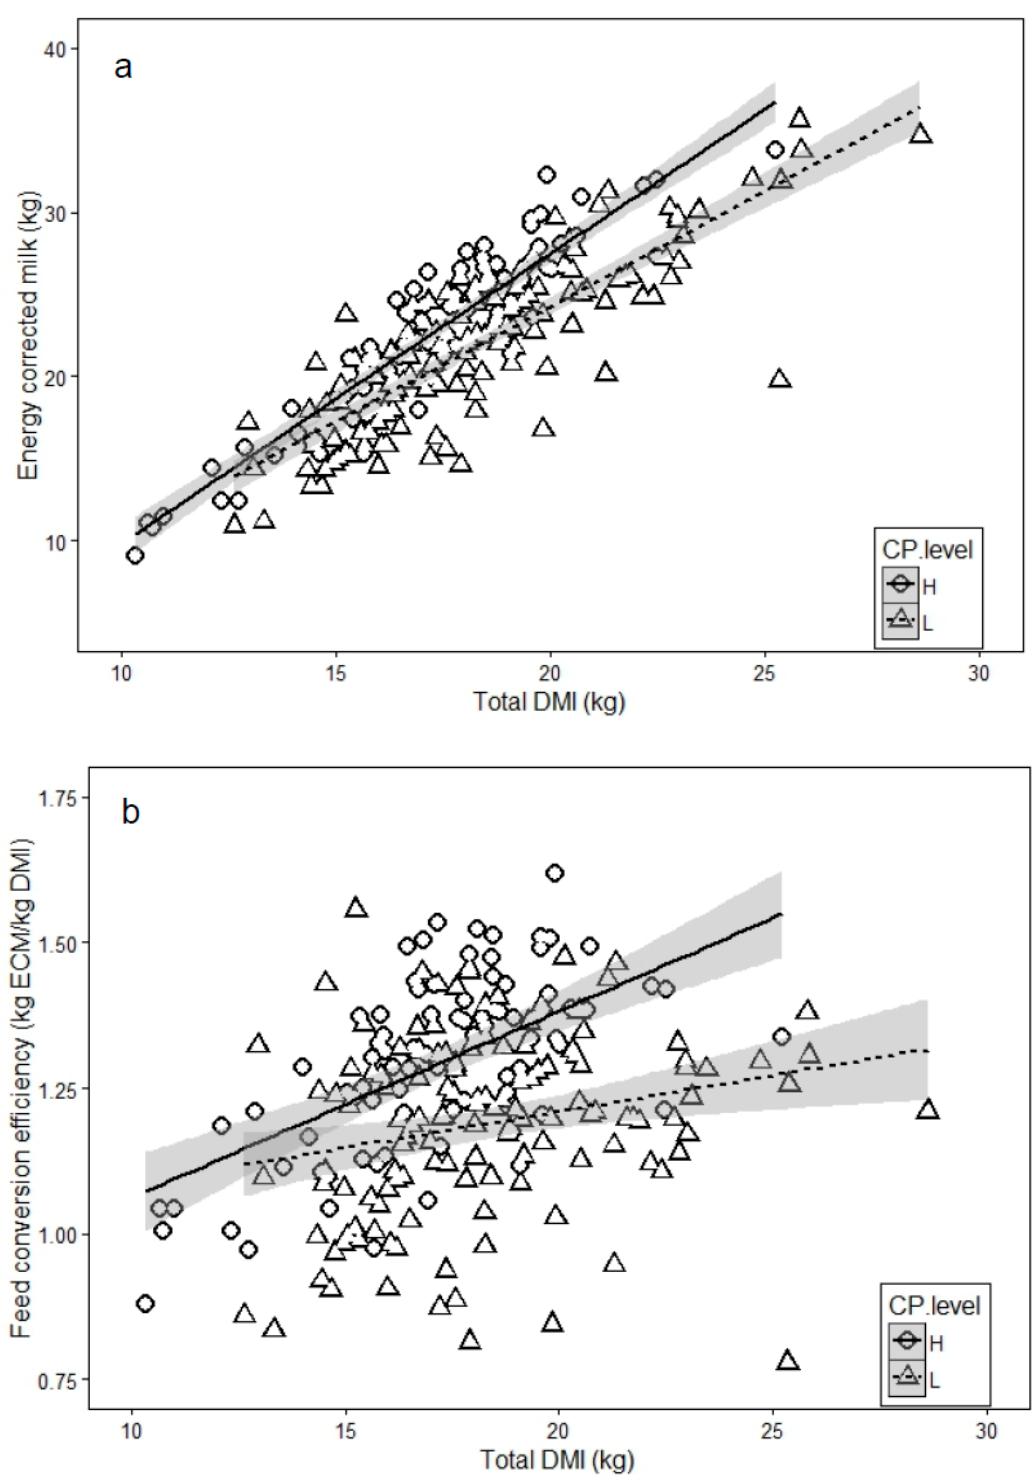
Figure 1. Relationship between energy corrected milk (ECM); ( a ) or feed conversion efficiency ( b ) and total dry matter intake (DMI) by lactating dairy herds on 43 grazing system dairy farms at low (L; <20%) and high (H; >20%) dietary crude protein (CP). Graphs were prepared using R Studio 0.99.891. Shaded areas represent 95% confidence intervals around the regression lines.